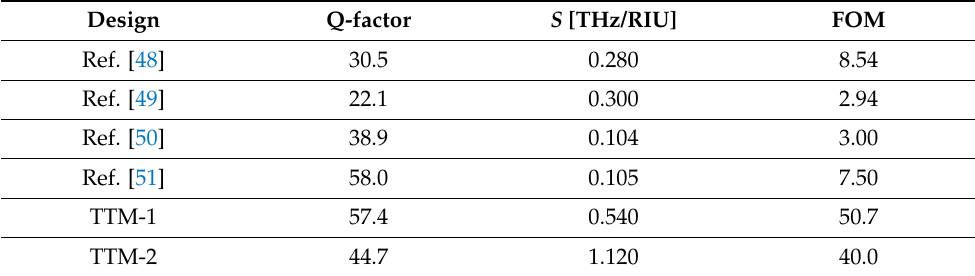
Table 2. Comparison of the proposed sensor with prior presented